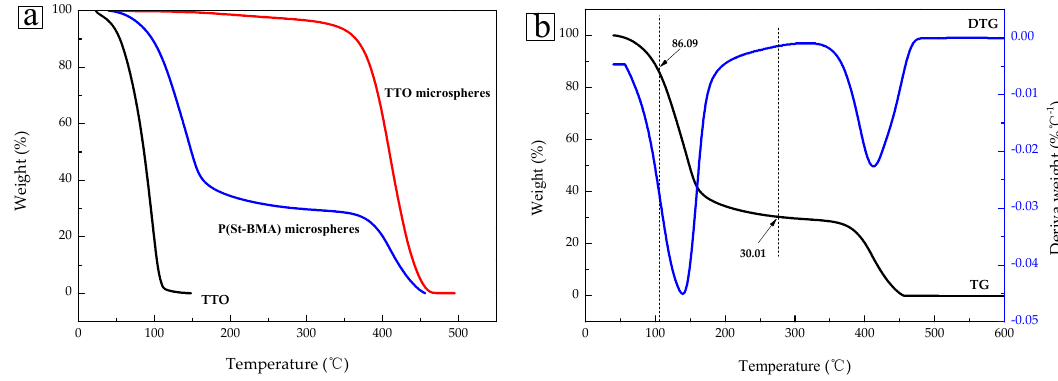
Figure 3. ( a ) TGA curves of TTO, P(St-BMA) microspheres, and TTO microspheres, and ( b ) TGA and DTG curves of the TTO microspheres.